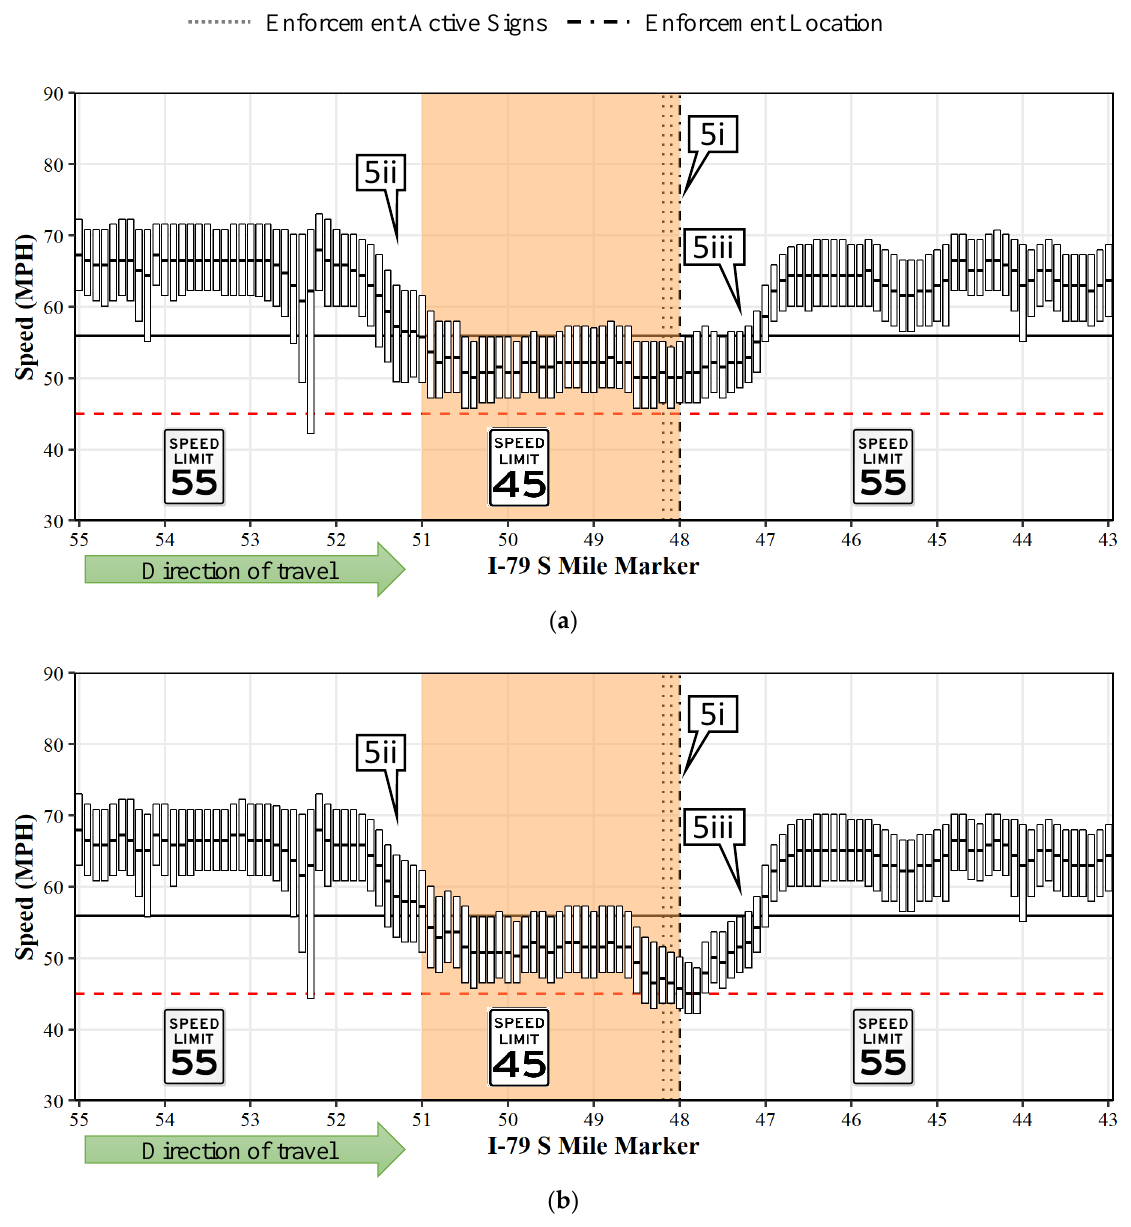
Figure 5. IQR plots comparing impact of enforcement on I-79 SB work zone. ( a ) Enforcement absent. ( b ) Enforcement present. Callout 5i shows the enforcement location; 5ii highlights the reduction in speed before entering the work zone; and 5iii highlights the increase in speed after exiting the work zone.